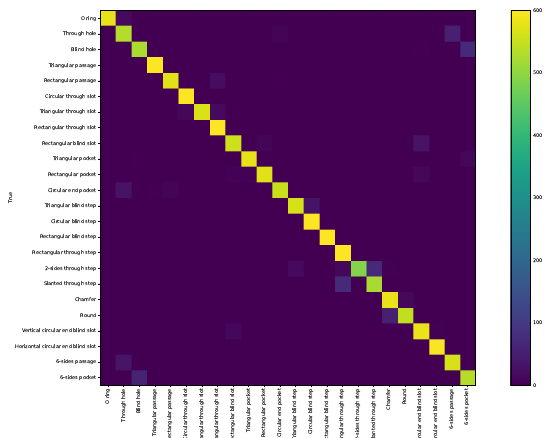
Figure A1. Confusion matrix for FeatureNet